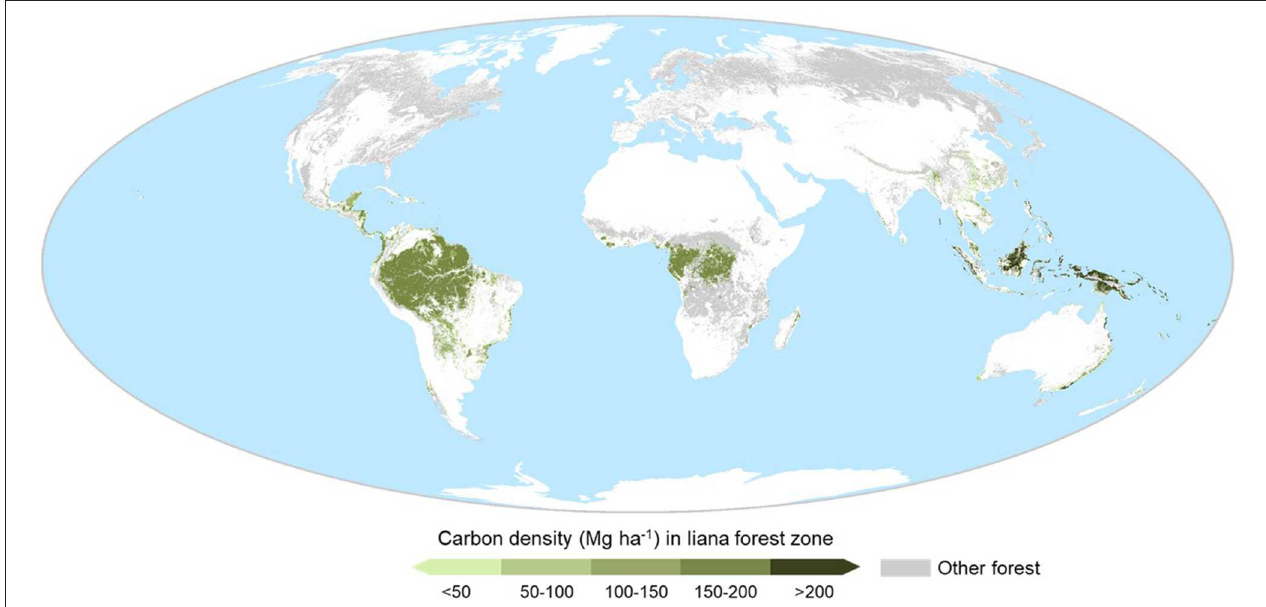
FIGURE 2 | Expected location and live (above- and below-ground) woody carbon stock, of forest with conditions most favourable for lianas. This expected liana forest cover was derived from the ESA Climate Change Initiative (version v2.0.7; 2015; http://maps.elie.ucl.ac.be/CCI/viewer/index.php), land uses 50 (Tree cover, broadleaved, evergreen, closed to open [ > 15%]) and 61 (Tree cover, broadleaved, deciduous, closed [ > 40%]), − 40 to + 40 degrees latitude and ≤ 1,000m elevation. Other forests are shown in grey, including land use 62 (Tree cover, broadleaved, deciduous, closed [ > 15%]), which comprised large areas of dry open woodland, unsuitable for liana proliferation. Carbon estimates sourced from Ruesch and Gibbs